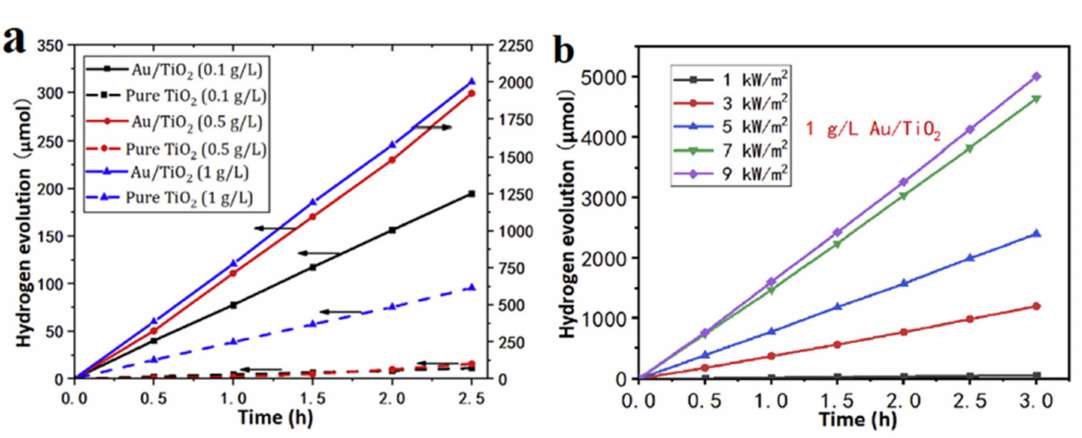
Figure 6. ( a ) Hydrogen evolution of pure TiO 2 nanoparticles and Au / TiO 2 nanoparticles at the same light intensity of 5 kW / m 2 ; ( b ) Hydrogen evolution in 1–9 kW / m 2 light intensities of 1 g / L Au / TiO 2 solutions. Both figures are reprinted from [63], with permission from Elsevier,